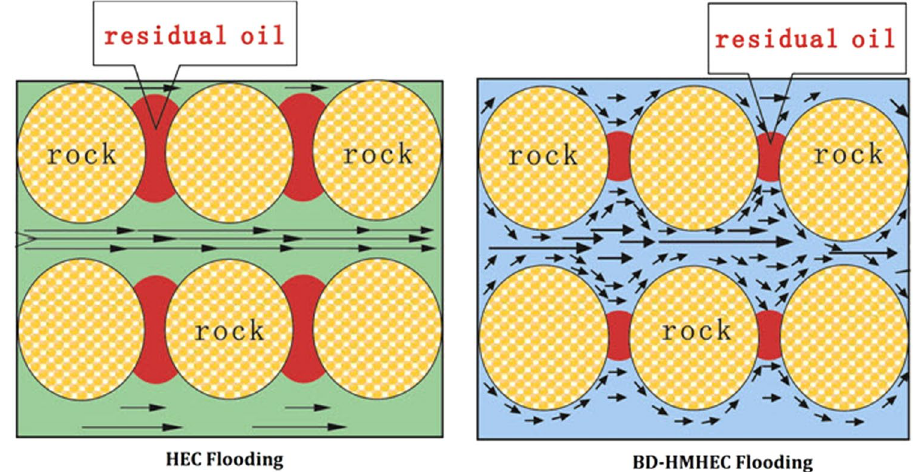
Figure 10. A schematic of the flooding process of oil droplets in water-wet cores.